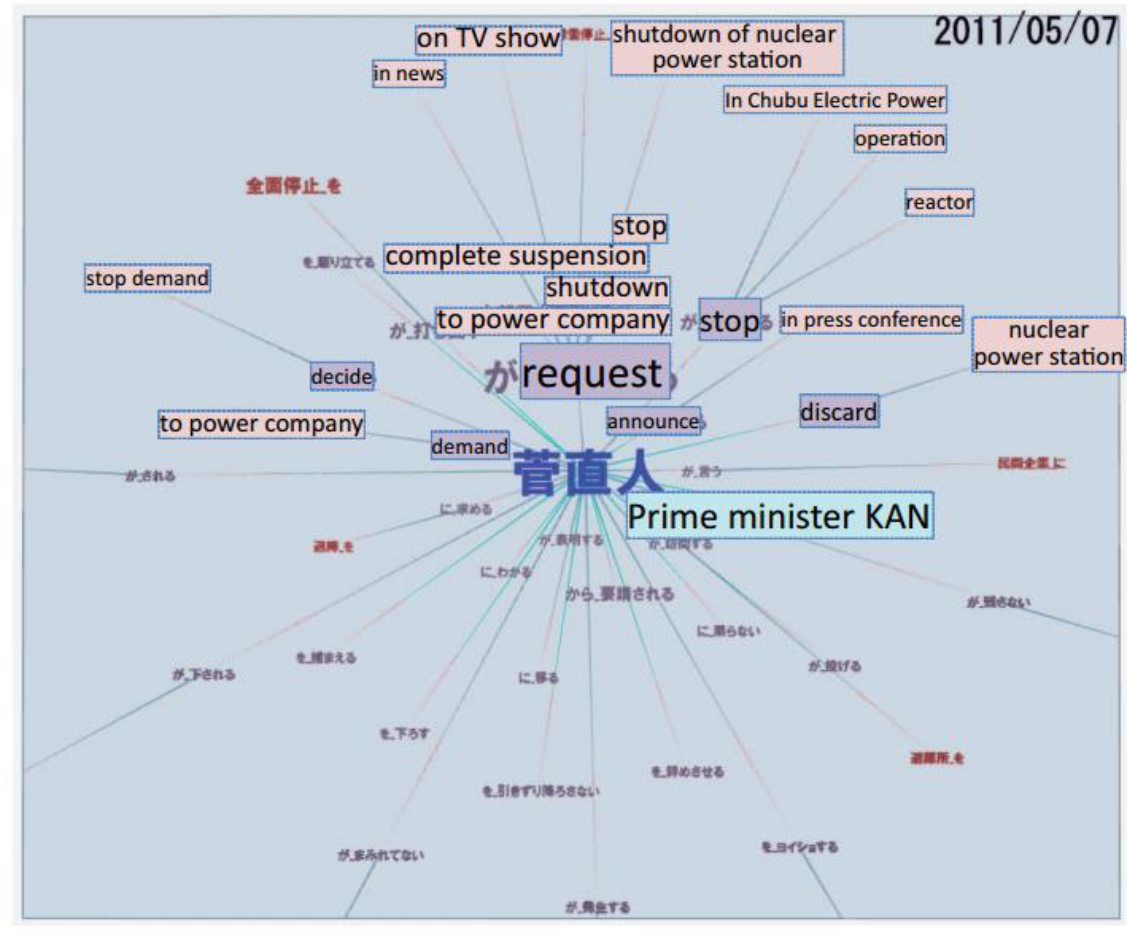
Figure 3 Event view showing via